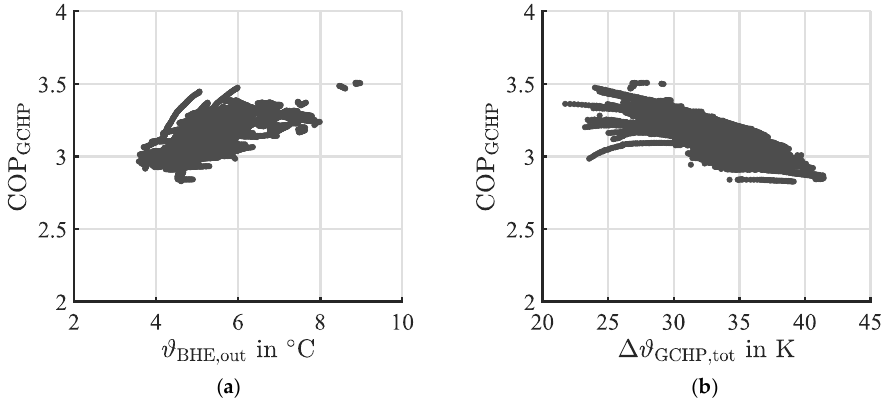
Figure 8. ( a ) GCHP electrical COP in dependence of BHE outlet temperature ϑ BHE,out ; ( b ) total GCHP temperature lift ∆ ϑ GCHP,tot .